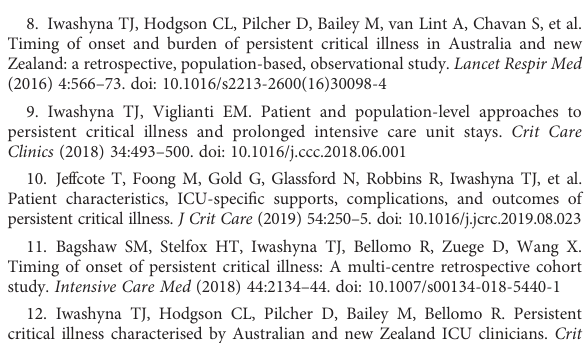
SUPPLEMENTARY FIGURE 4 Learning curves for machine learning. (A) Random Forest; ( B ) Gradient Boosting Machine. SUPPLEMENTARY FIGURE 5 Learning curves for machine learning. (A) Decision Tree; (B) Support Vector Machine; (C) Logistic Regression. SUPPLEMENTARY FIGURE 6 Analysis of model predictors in terms of SHapley Additive exPlanations. It presents how the Shapley value distribute in each predictor. The color represents the eigenvalue, andred indicates highvalue (risk contributor to the outcome) and blue indicates low value (protective contributor to the outcome) in the study. SUPPLEMENTARY FIGURE 7 Area under the receiver operating characteristic curve (AUROC) for a comparison among the random forest algorithm, the Oxford Acute Severity of Illness Score (OASIS), the Simpli fi ed Acute Physiology Score II (SAPS-II), and the Sepsis-related Organ Failure Assessment score (SOFA). SUPPLEMENTARY FIGURE 8 Feature importance of model predictors in terms of the gradient boosting machine algorithm. SUPPLEMENTARY FIGURE 9 Feature importance of model predictors in terms of the decision tree algorithm. SUPPLEMENTARY FIGURE 10 Kaplan-Meier curve shows cumulative hazard strati fi ed by risk strati fi cation system in the external validation cohort (P=0.024, Log- rank test). “ Sky bule ” indicates patients in the low-risk group; “ Red ” indicates patients in the high-risk group. SUPPLEMENTARY FIGURE 11 Line chart for the dynamic changes of the mean level of lymphocytes (%) with time after ICU admission between patients in the low-risk group (sky-blue line) and patients in the high-risk group (red line). The black dotted line indicates normal reference range. SUPPLEMENTARY FIGURE 12 Dynamic changes of the mean level of lymphocytes (%) with time after ICU admission between patients in the low-risk group (sky-blue dots) and patients in the high-risk group (red dots). The blue-sky dotted line indicates normal reference range. The red and sky-blue dots are fi tted by smooth lines